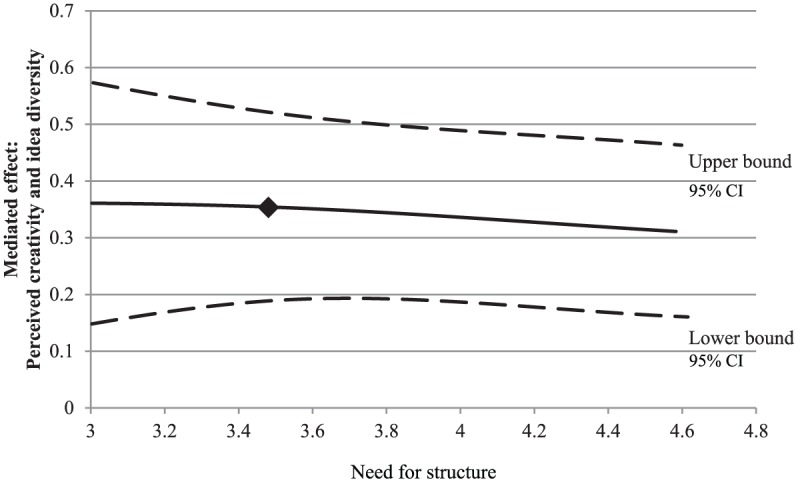
Study 1: A plot of the conditional indirect effect of input novelty
on idea diversity through perceived creativity, conditioned on the
moderator (need for structure), with 95% confidence bands.Note. The square indicates the mean level of the
need strength. CI = confidence interval.